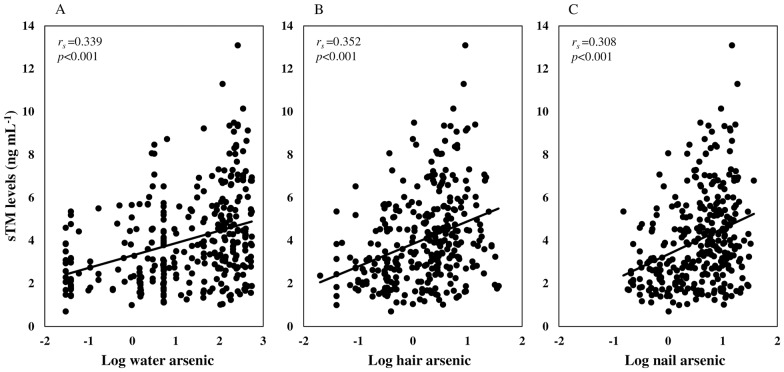
Association between arsenic exposure and serum sTM levels.Log10-transformed values of water (μg L-1), hair (μg g-1), and nail (μg g-1) arsenic concentrations were used. rs and p-values were from Spearman correlation coefficient test.